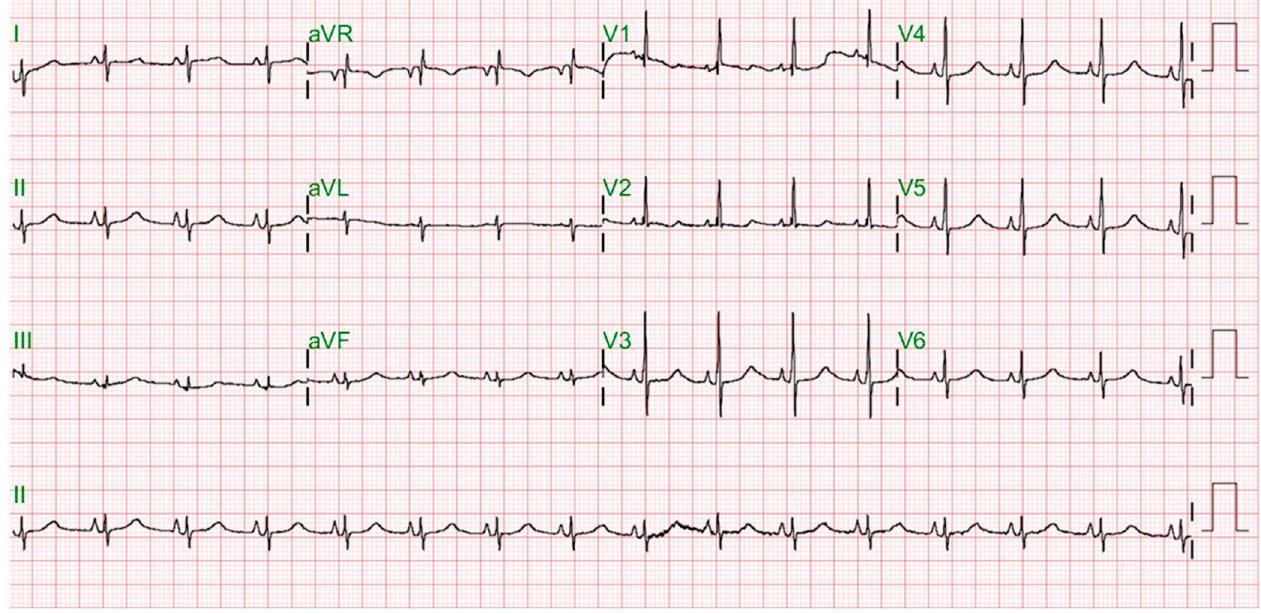
Figure 4. ECG after propranolol and mexiletine treatment showing normal sinus rhythm with a QTc interval of 400 ms under an HR of 92 bpm.